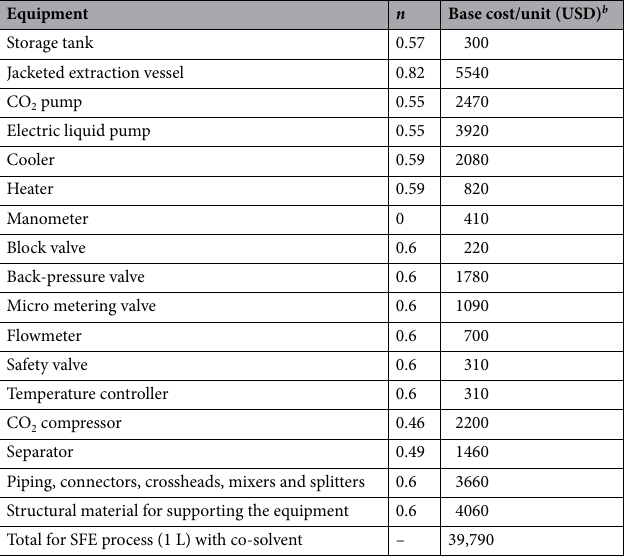
Table 5. Base cost of different equipment for 1 L SFE system ( Source : Pereira et al. 25 ). n Constant depending on equipment type, b Based on 1 L SFE system.